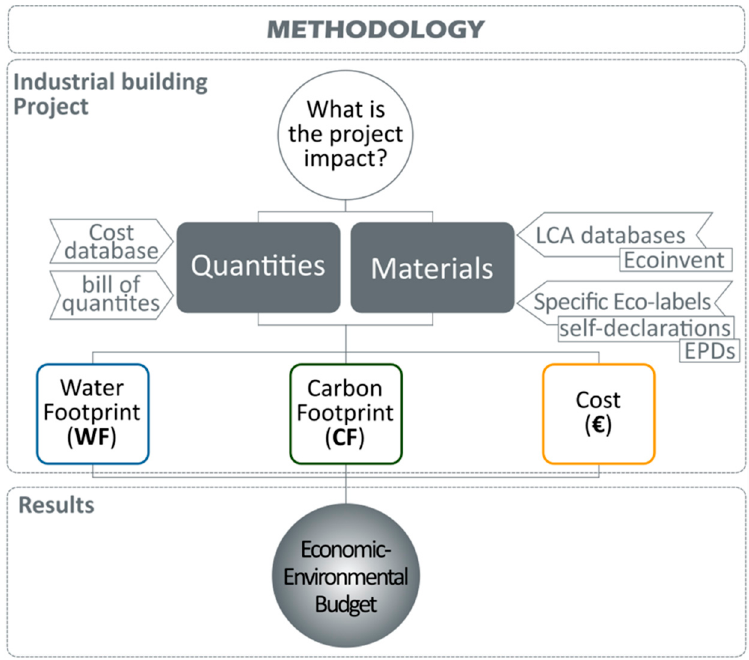
Figure 1. Methodology for the inclusion of the WF (m 3 water ) and CF (tCO 2 eq) in the green assessment of industrial projects.